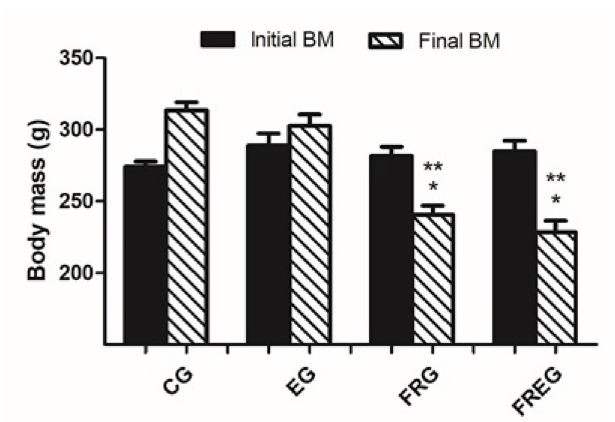
Figure 1 - Data from initial body mass showed no difference between groups (p>0.05) in control (CG), exercised (EG), food restriction (FRG), and food restriction/ exercised (FREG) from female rats. Comparing data from final body mass, *p<0.05 in relation to CG and **p<0.05 in relation to EG, showing the lower ES of 3.19. When analyzed initial versus final for the same group were found significant differences for all (p<0.05). BM: body mass; g: grams; mg: miligram.